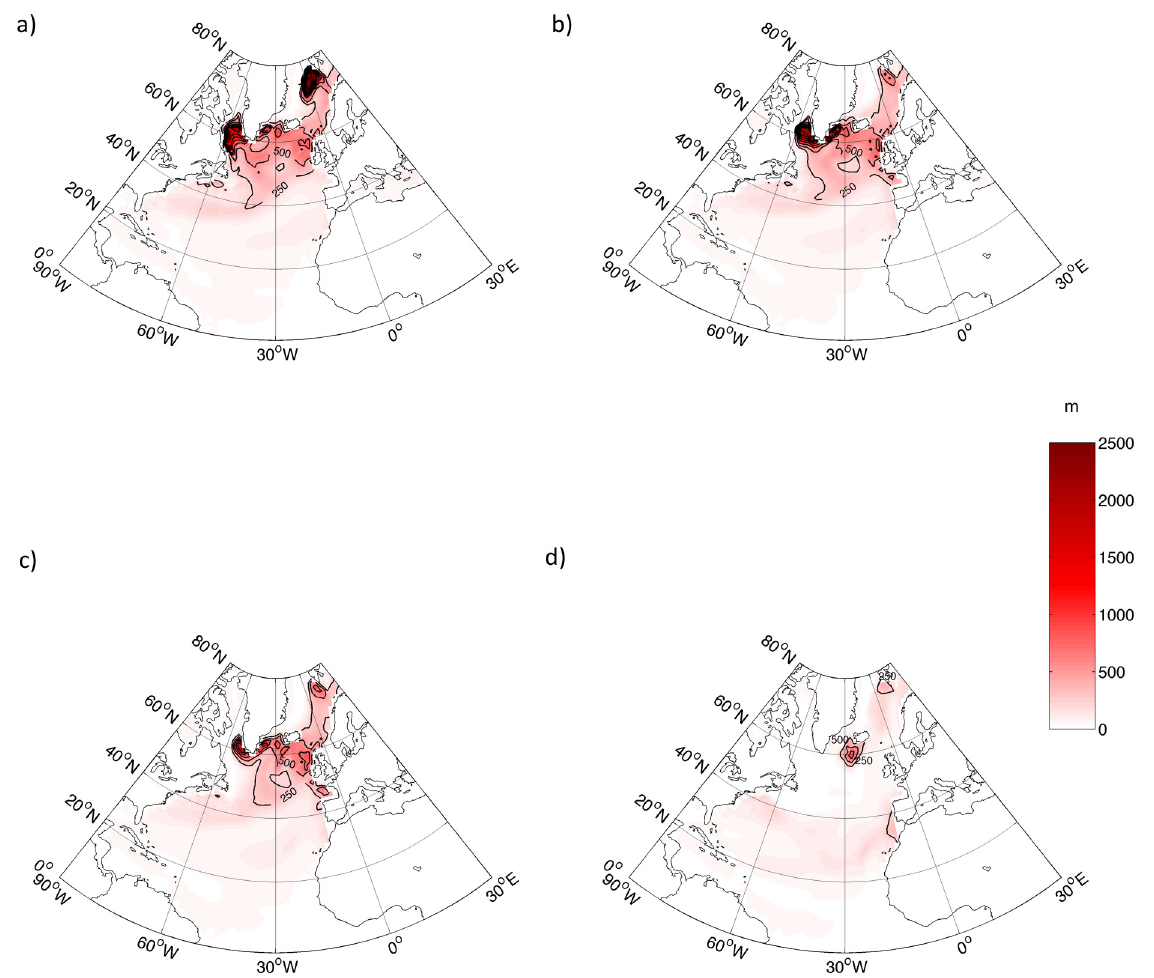
, (c) 8CO and (d) 16CO 2 2 2